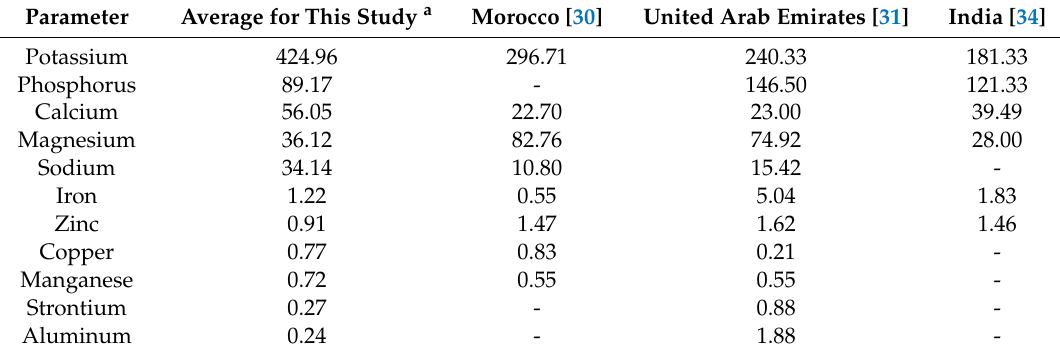
Table 9. Comparative analysis minerals content of the average obtained from the four treatments used in this study, against studies developed in the Medjool seeds in Morocco, United Arab Emirates and India. All expressed in mg / 100 g dry